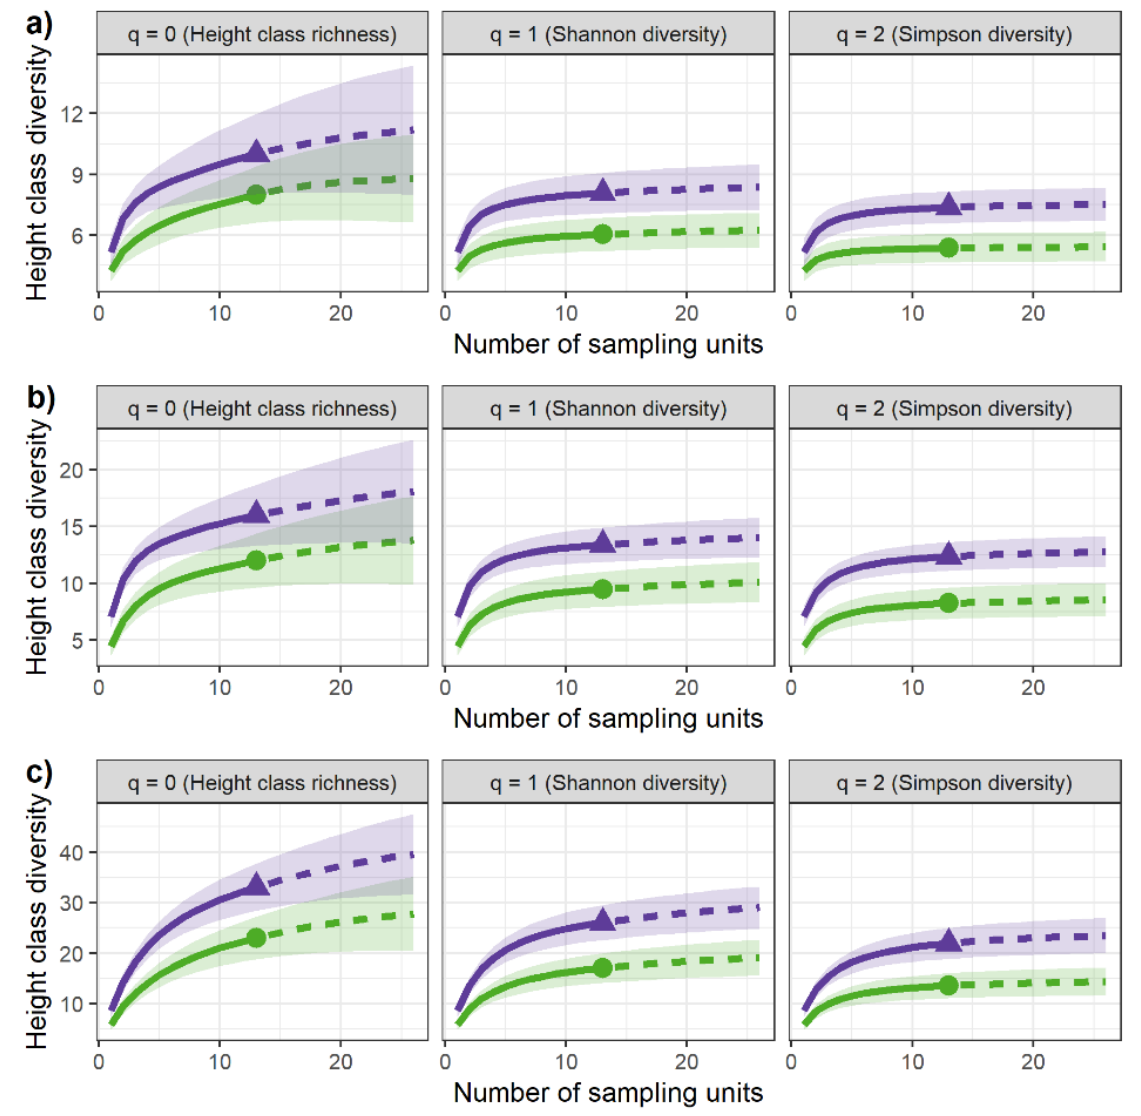
Figure 4. Empirical diversity profiles of sample-based rarefaction (solid lines) and extrapolation (dashed lines) curves for incidence-based tree height class data collected on control plots (green, point) and exclosure plots (purple, triangle) for Hill numbers of order q ( q = 0, species richness; q = 1, Shannon diversity; q = 2, Simpson diversity), ( a ) 9 years, ( b ) 18 years, and ( c ) 30 years after establishment of study plots. The 95% confidence intervals were obtained from bootstrapping based on 400 replications. Please note the different, scaled y-axes in the